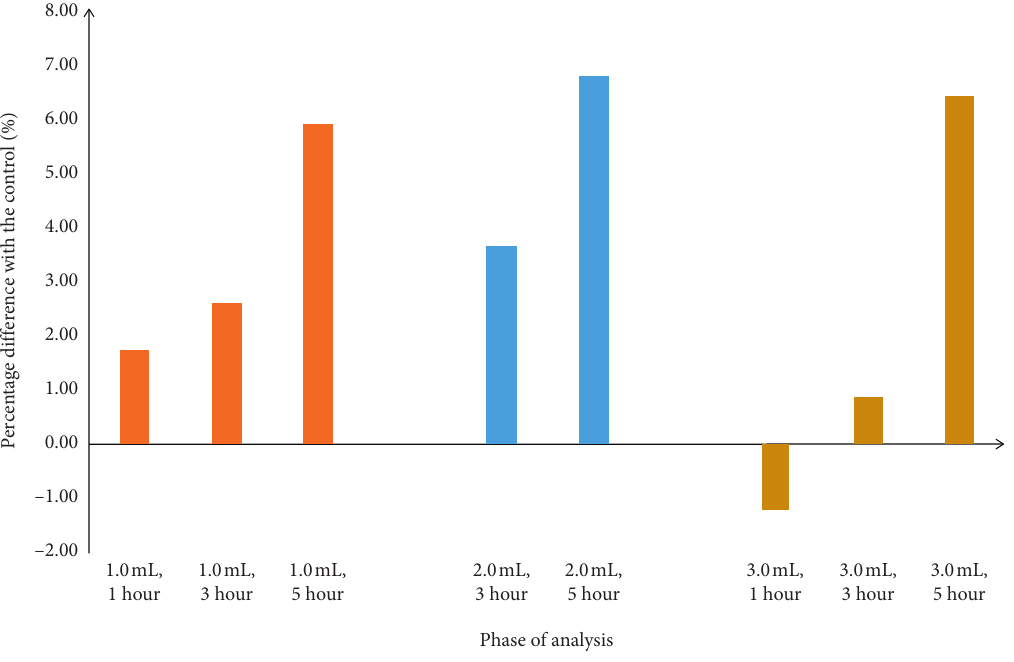
Figure 1: Percentage differences of mean values in each phase of analysis. Table 2: Mean comparison of different analysis times at constant sample volumes. Time between sample collection and analysis